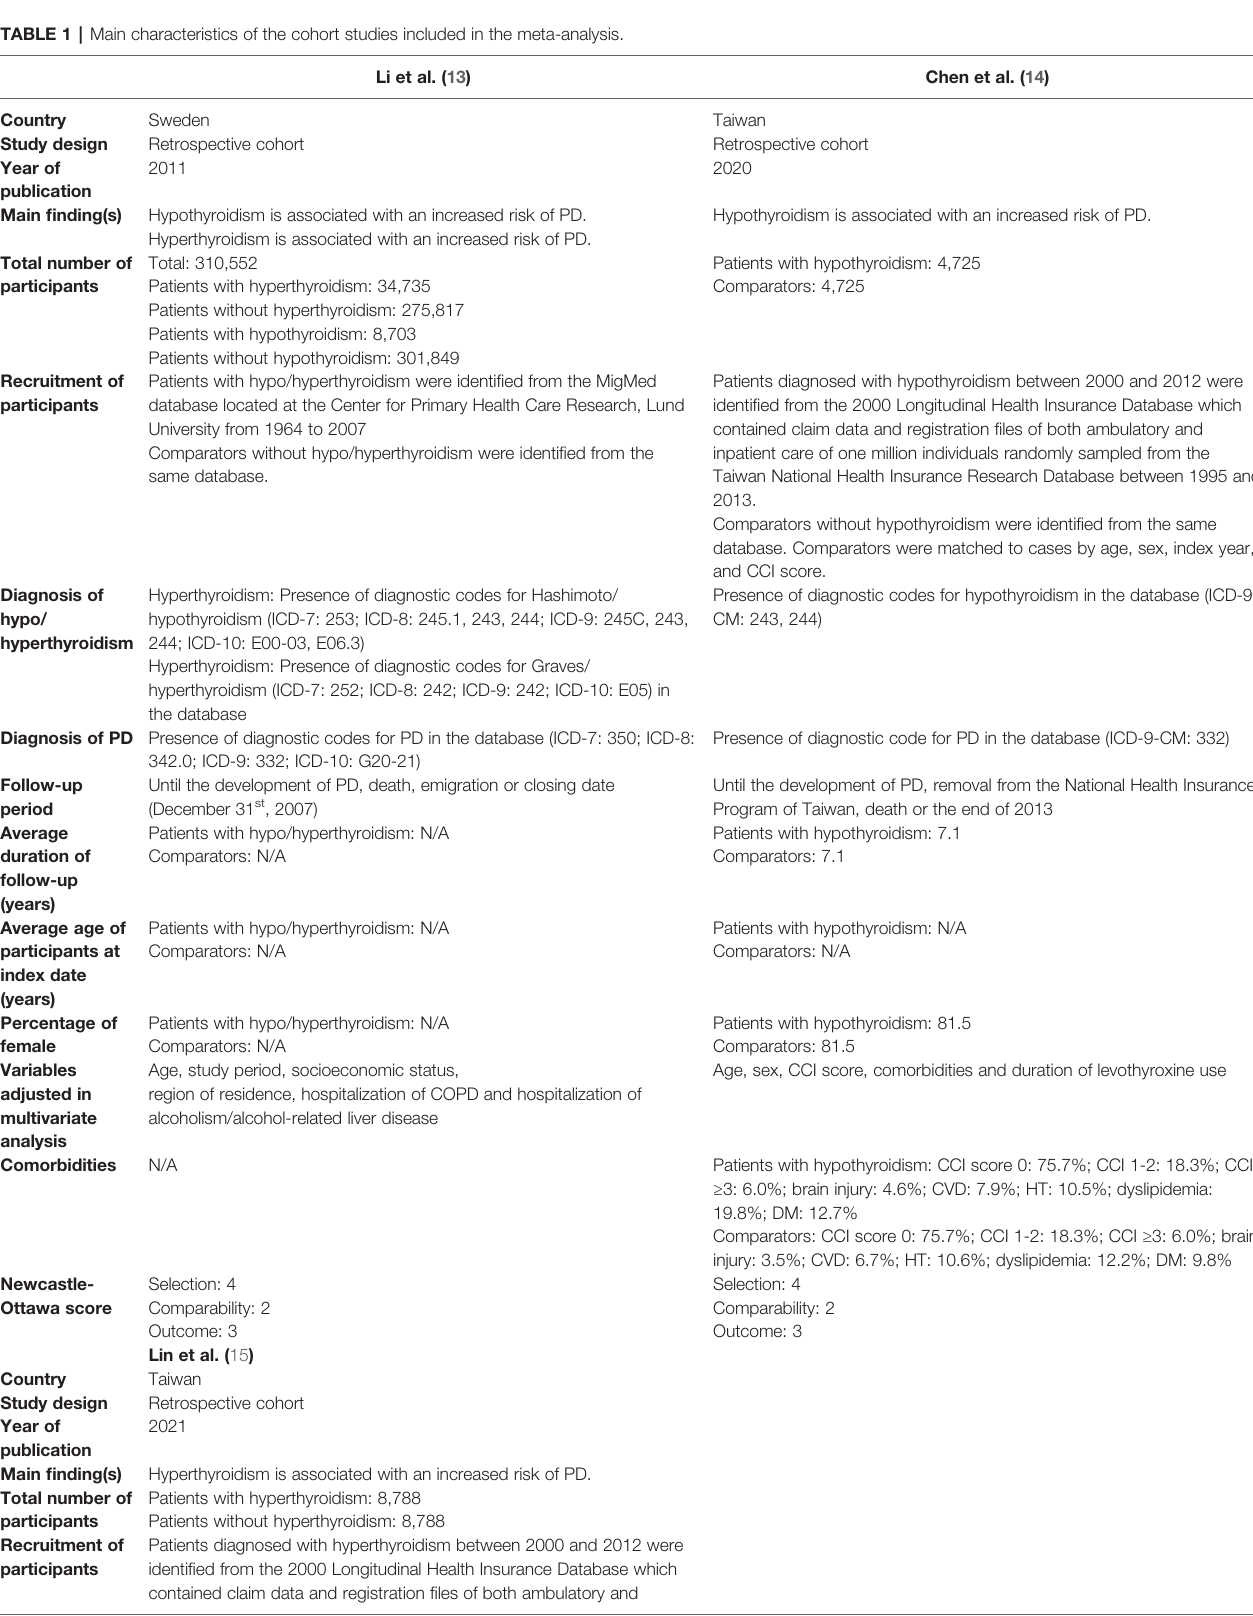
TABLE 1 | Main characteristics of the cohort studies included in the